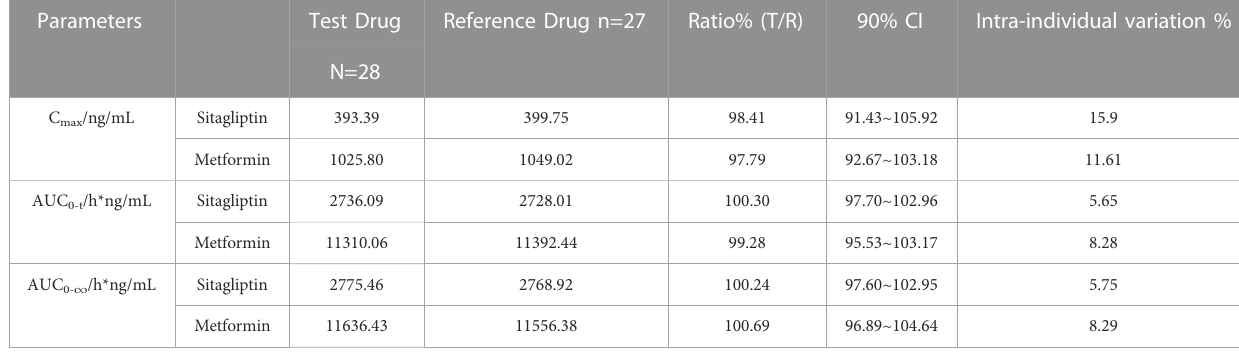
TABLE 5 Statistical comparison of Sitagliptin and Metformin Pharmacokinetic parameters under fed state.